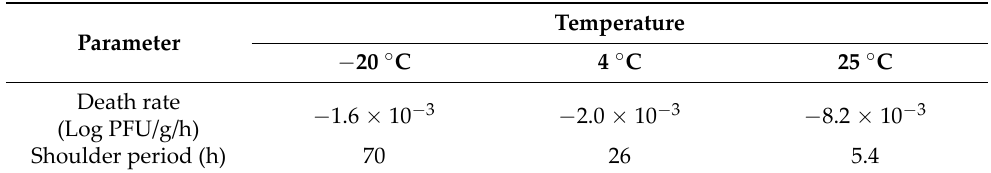
Table 1. Kinetic parameters for hepatitis A virus in fermented clams calculated from the primary predictive model.